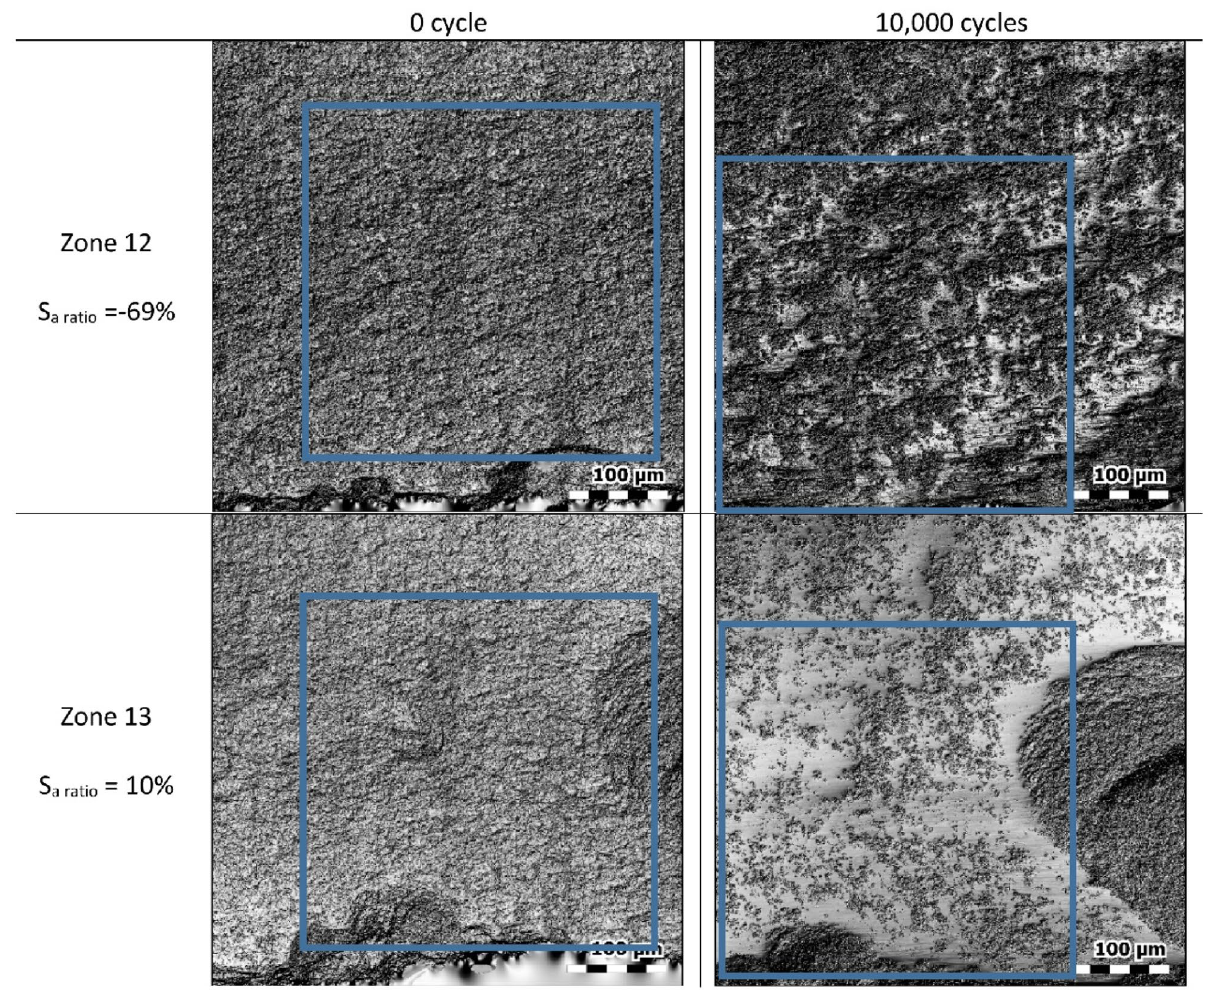
Figure 1. Photo simulation images of two locations and corresponding Sa ratios. Matching sub-surfaces are shown by the blue rectangles for each